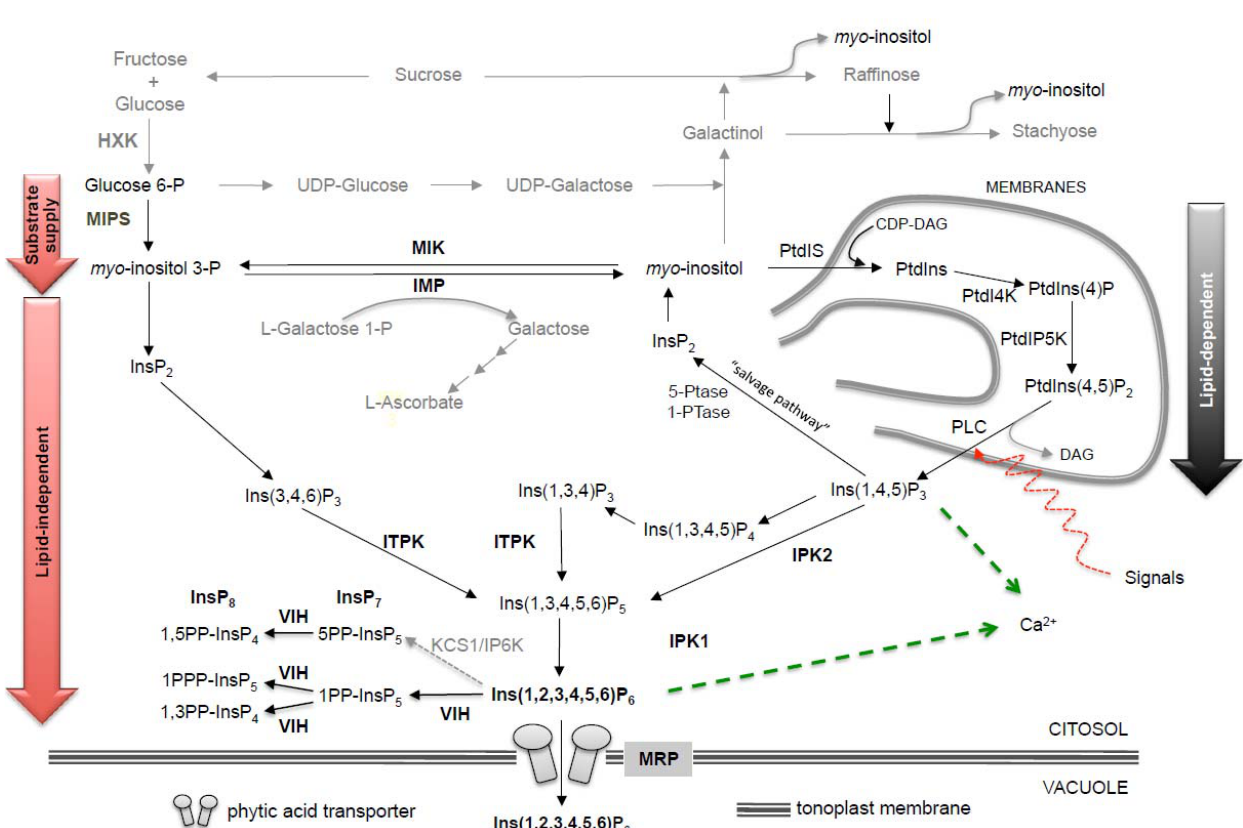
Figure 1. Schematic representation of phytic acid biosynthetic pathway (black) and myo -inositol derived pathways for ascorbic acid and raffinose-type oligosaccharides (grey). The substrate supply, lipid independent (red) and lipid dependent (dark grey) sub-pathways for myo- inositol-1,2,3,4,5,6-hexakisphosphate (InsP 6 ) synthesis are indicated. MIPS, myo -inositol-3- phosphate synthase; IMP, bifunctional enzyme: myo -inositol-phosphate monophosphatase and galactose-1-phosphate phosphatase; MIOX, myo -inositol monooxygenase; MIK, myo - inositol kinase; IPK2, inositol 1,4,5-tris-phosphate kinase; ITPK, inositol 1,3,4-triphosphate 5/6-kinase; IPK1, inositol 1,3,4,5,6 penta kis phosphate 2-kinase; PtdIS, phosphatidyl inositol phosphate synthase; PtdI4K, phosphatidyl inositol 4-kinase; PtdIP5K, phosphatidyl inositol 4-phospate monophosphate; PtdInsP 2 , phosphatidyl inositol biphosphate; PLC, phospholipase C; MRP, multidrug-resistance-associated protein ATP-binding cassette; HXK, hexokinase; VIH, diphosphoinositol pentakisphosphate kinase; KCS1, inositol hexakisphosphate kinase. Dotted grey line indicates a second route for InsP 7 synthesis, existing in eukaryotes but not found in